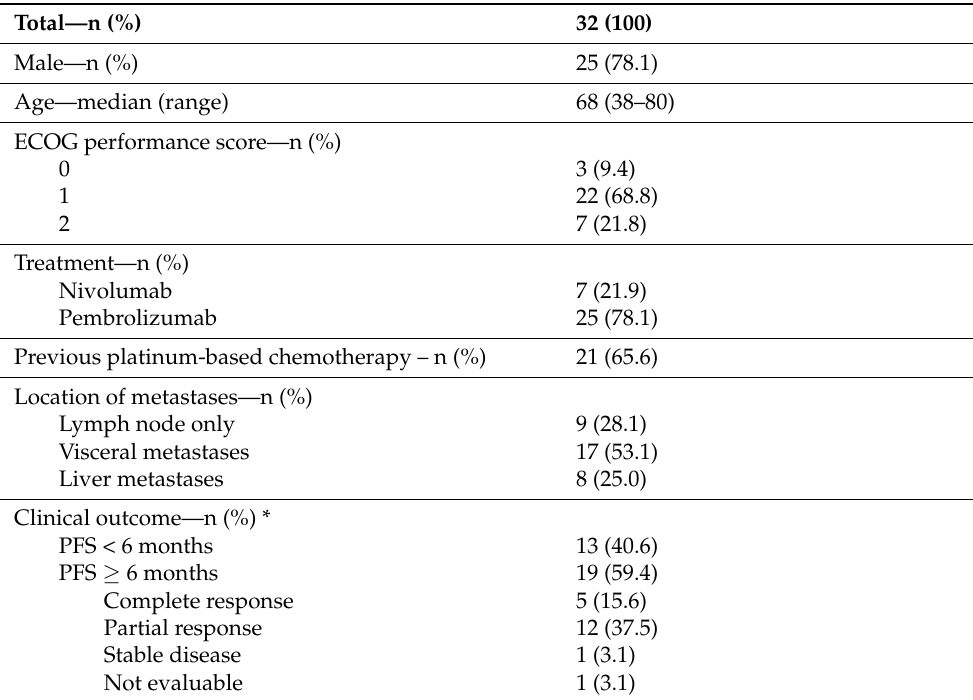
Table 1. Patient